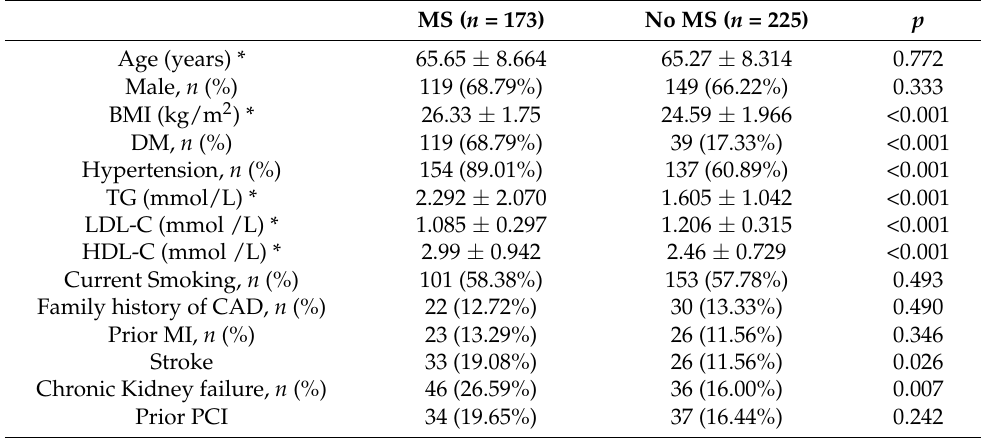
Table 1. Patient characteristics at baseline.